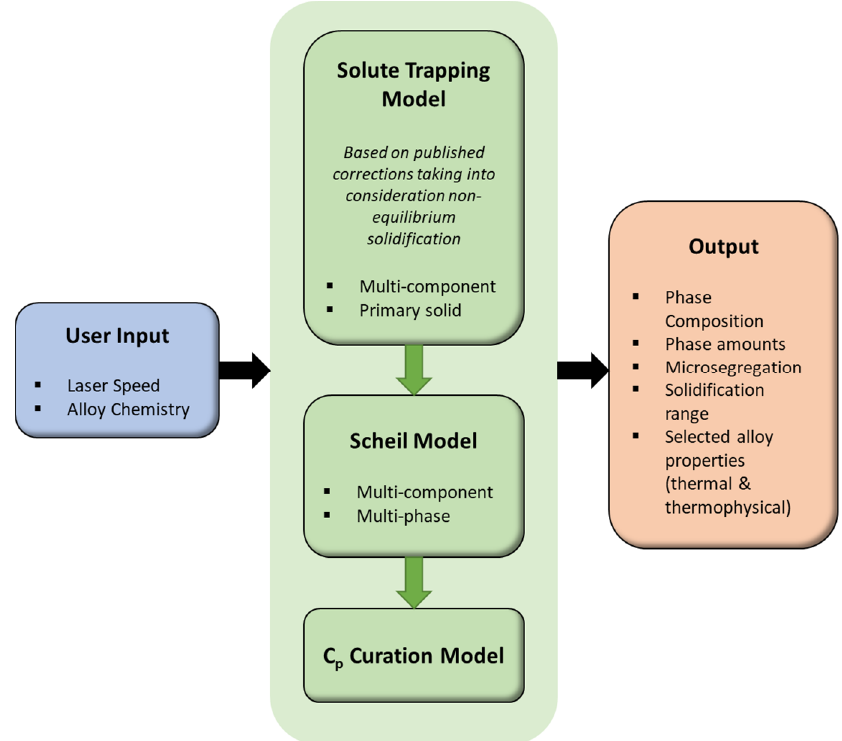
Figure 9. A computational framework [45] for predicting microsegregation in AM. It uses previously published modifications made to the Scheil model that account for solute trapping. The ‘Cp curation model’ refers to the calculation of specific heat as a function of chemistry and temperature using the Thermo-Calc software. The figure is adapted from that work.